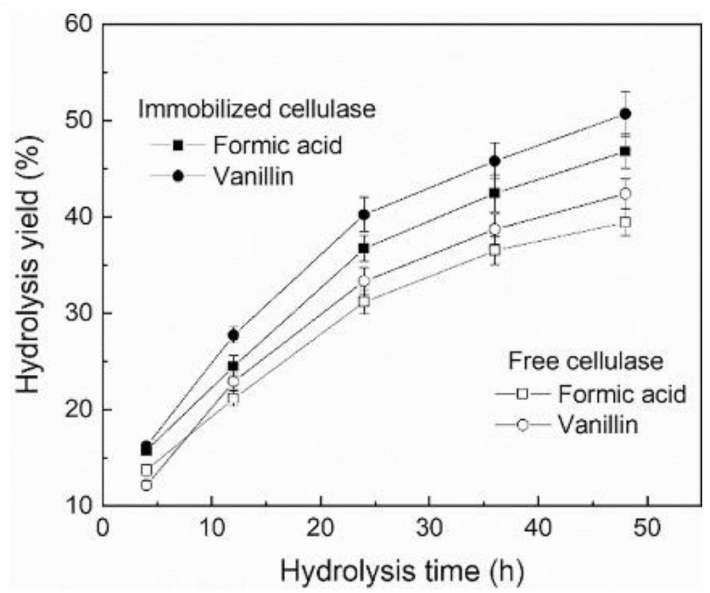
Figure 3. Enzymatic hydrolysis of microcrystalline cellulose in the presence of inhibitors (5 g L − 1 ) at 50 ◦ C using free and immobilized enzyme on magnetic MOF nanoparticles. The product (glucose) was determined by HPLC using ion-exclusion chromatography (reproduced from [21] with permission from